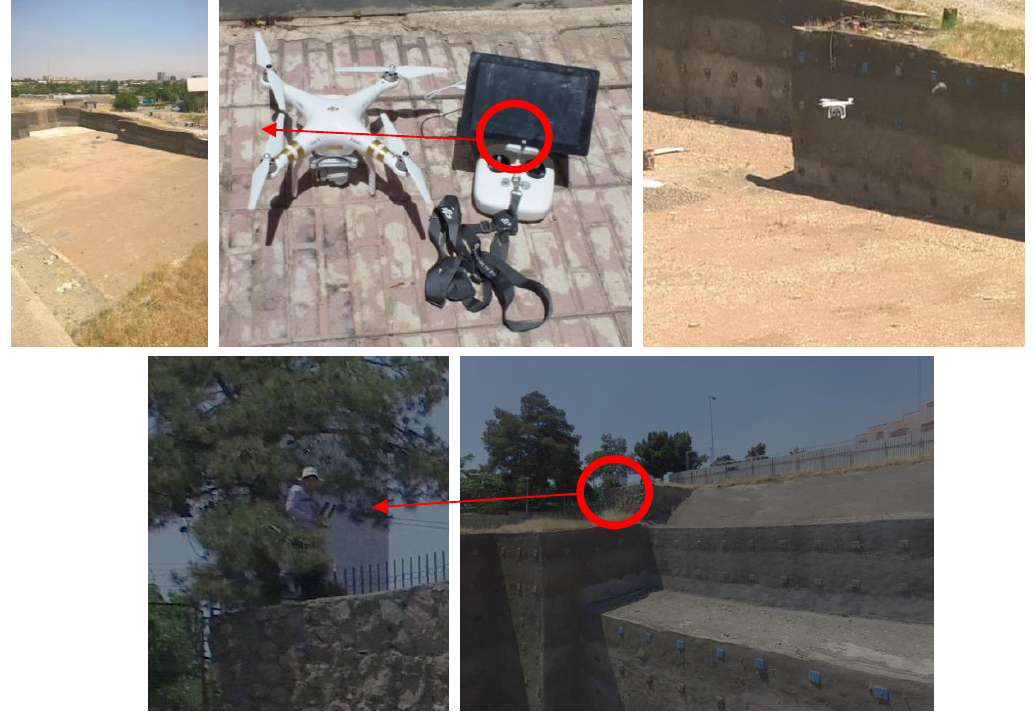
Figure 11. The Phantom 3 Pro when imaging the Seoul excavation pit, along with the drone pilot.